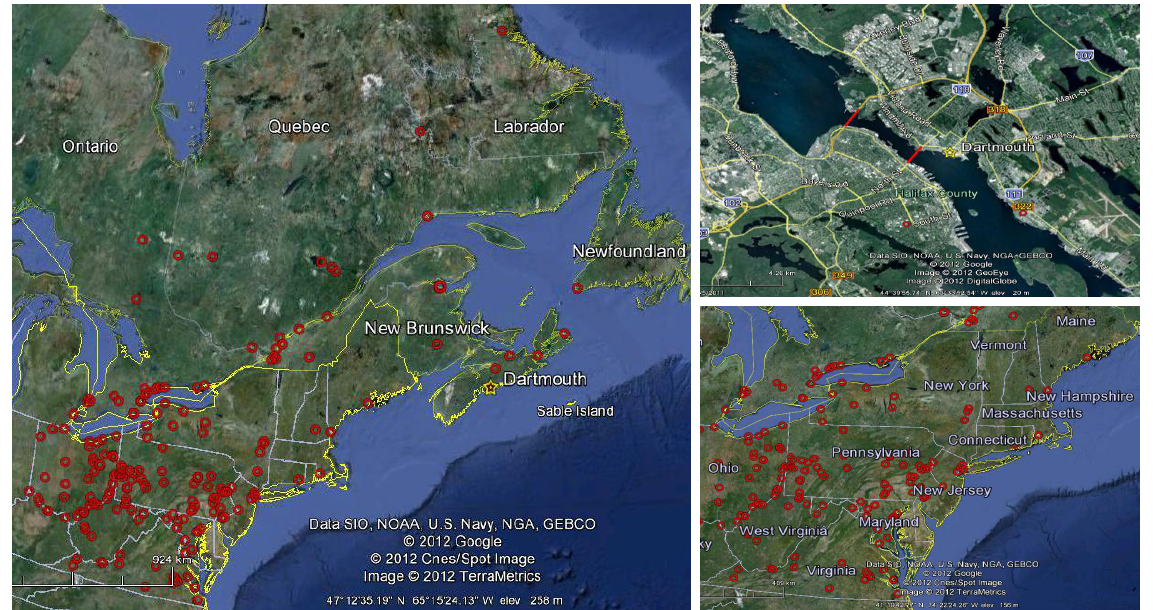
Fig. 1. Map showing the Dartmouth site and the locations of known industrial Hg sources (labeled with red circles) within a geographical domain. Top right and bottom right images are enlarged to show Dartmouth and the US northeast, respectively. Locations of known industrial Hg sources emitting > 5kgHgyr − 1 in 2010 and 2011 were retrieved from National Pollutant Release Inventory (Environment Canada, 2012) and Toxics Release Inventory (USEPA,